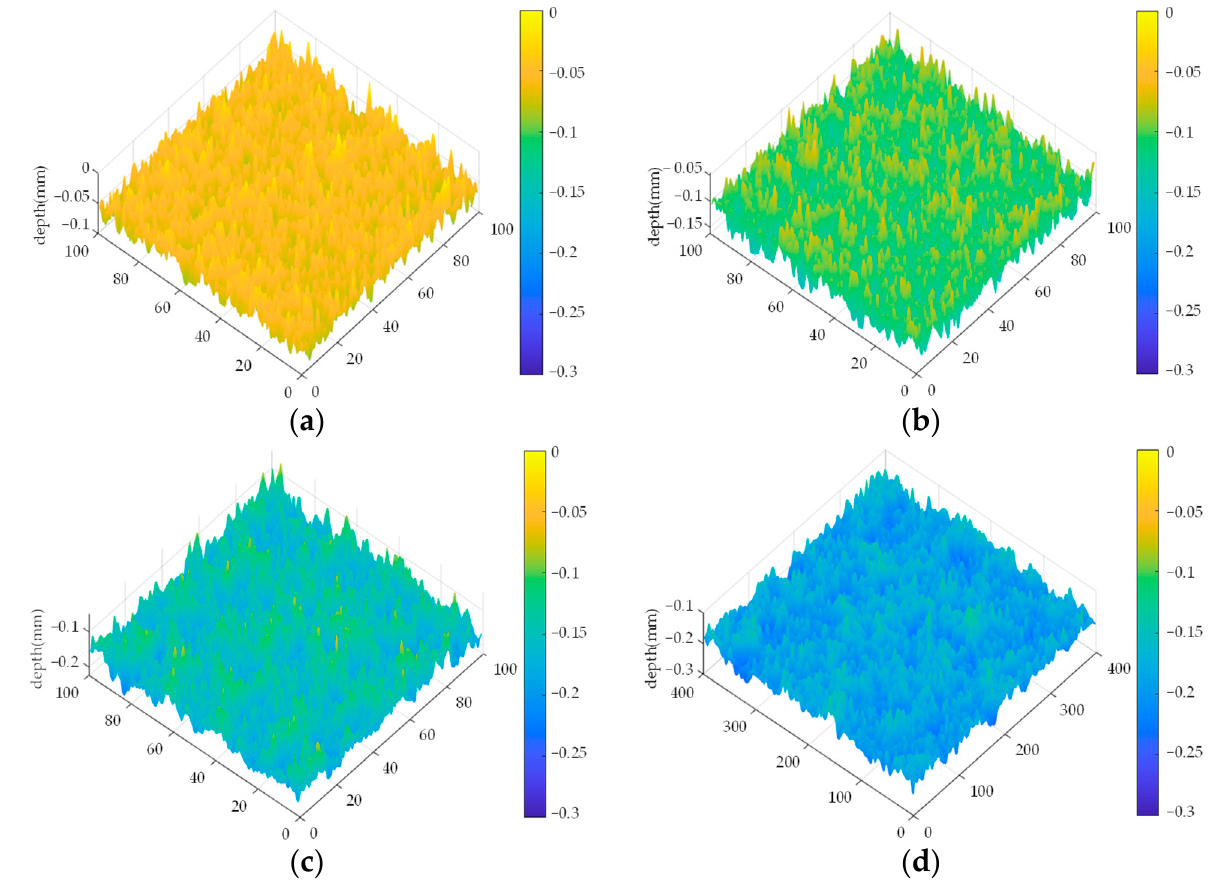
Figure 4. A steel’s surface atmospheric corrosion simulation results at different times. ( a ) steel corrosion simulation results in 1 year; ( b ) steel corrosion simulation results in 4 years; ( c ) steel corrosion simulation results in 8 years; ( d ) steel corrosion simulation results in 16